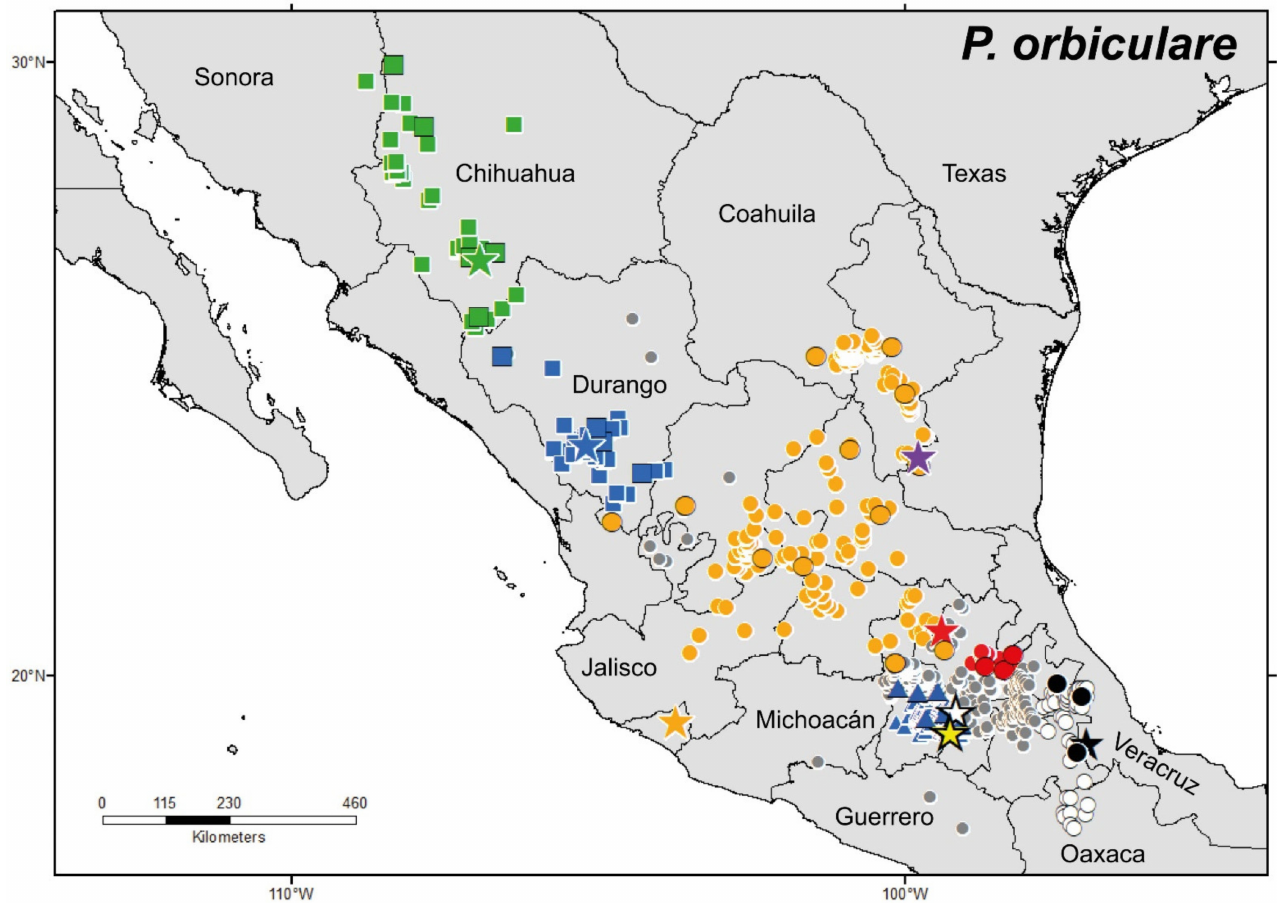
Figure 14. Map showing distributional records of Phrynosoma orbiculare . Green squares = P. o. bradti ; blue squares = P. o. durangoensis; orange circles = P. o. dugesii; red circles = P. o. boucardii; black circles = P. o. cortezii; blue triangles = P. o. orbiculare; symbols with black edges (except for stars) are localities from where specimens have been included in the analyses; gray circles = records that have not been genetically confirmed; white star = restricted type locality of Lacerta orbicularis and P. wiegmanni ; green star = type locality of P. o. bradti ; blue star = type locality of P. o. durangoensis ; orange star = type locality of Tapaya dugesii ; purple star = type locality of P. o. orientale ; yellow star = type locality of P. o. alticola ; black star = type locality of Tapaya cortezii ; red star = restricted type locality of Tapaya boucardii . The type locality of Tapaya orbicularis longicaudatus is too imprecise to